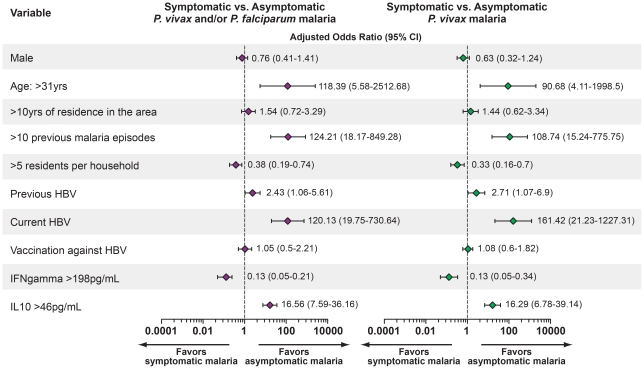
Adjusted multinomial logistic regression analysis of risk factors for asymptomatic malaria infection or for no malaria infection compared to symptomatic malaria.Symptomatic malaria infection was considered the primary outcome. Adjustment was performed for all variables presented. CI: Confidence interval. Individuals presenting AgHBS−/anti-HBS+/anti-HBc+ with no HBV DNA amplification by quantitative RT-PCR (qPCR) were considered to have previous HBV infection, those presenting AgHBS+/anti-HBS− and detectable viremia by qPCR were considered currently infected with HBV and those with AgHBS−/anti-HBS+/anti-HBc− were considered vaccinated against the virus. The statistical significance was estimated through multinomial logistic regression.